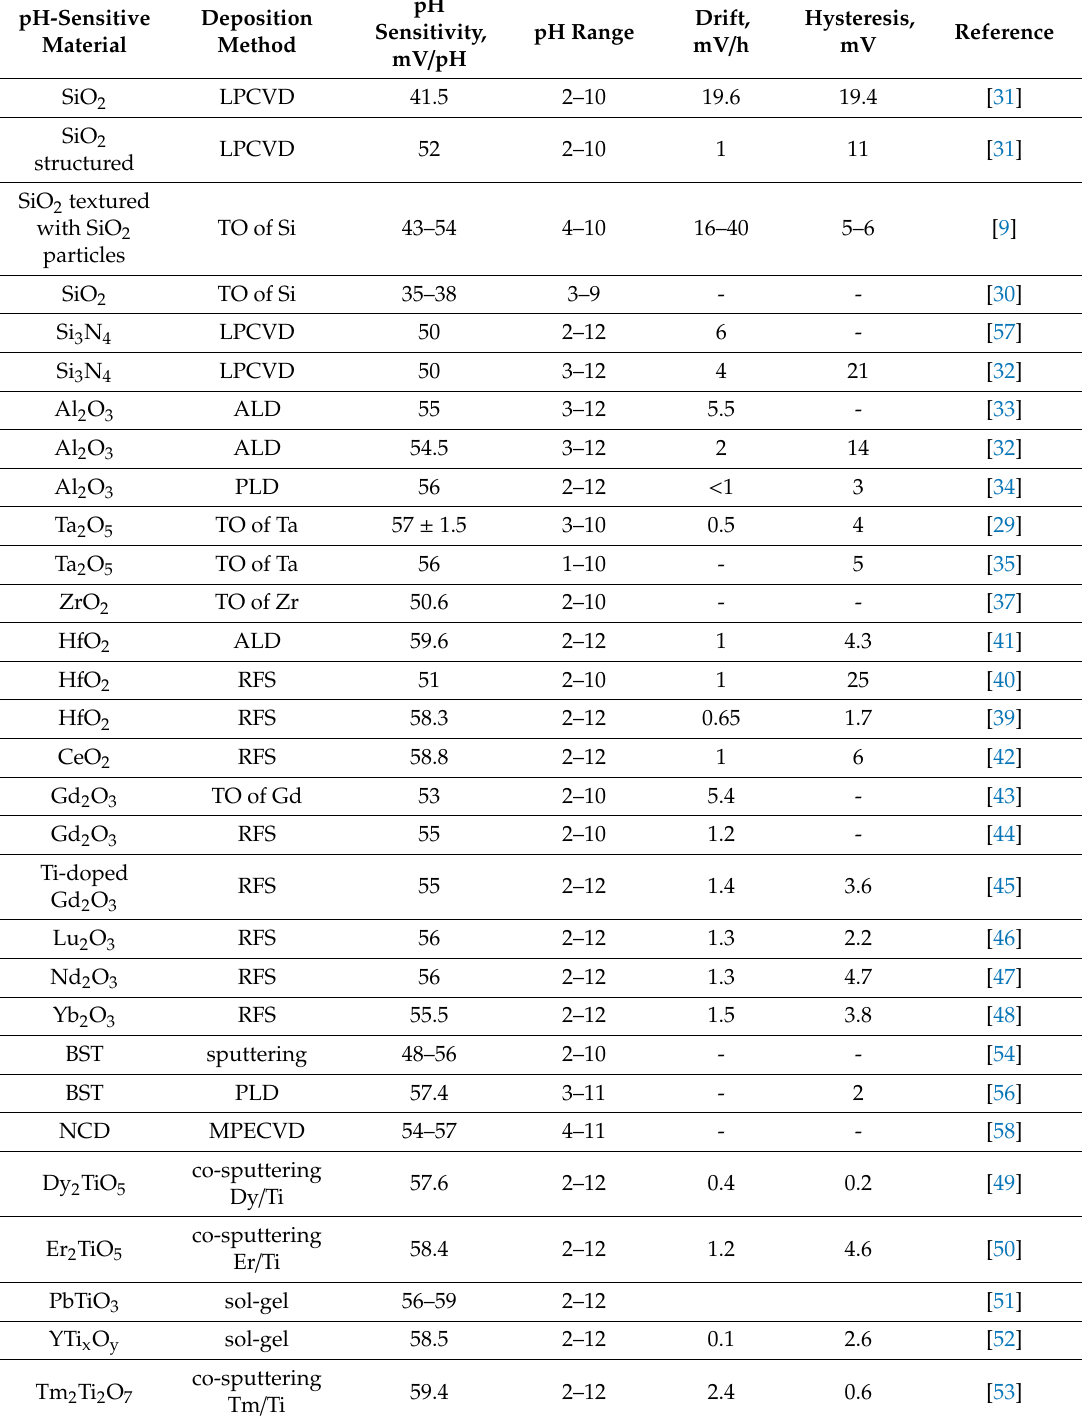
Table 1. Characteristics of electrolyte-insulator-semiconductor (EIS) pH sensors with di ff erent pH-sensitive materials and deposition